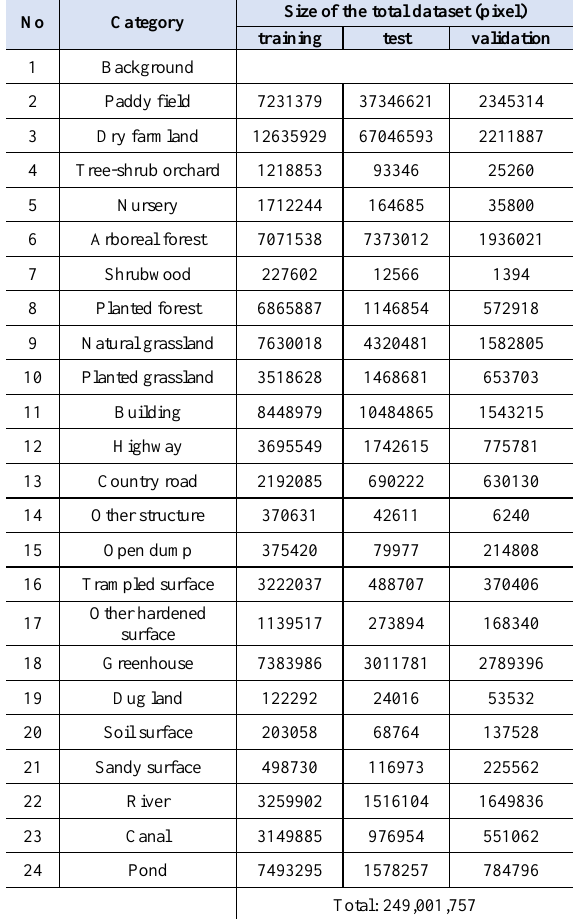
Figure 1. The architecture of FPGA (Zheng et al., 2020)